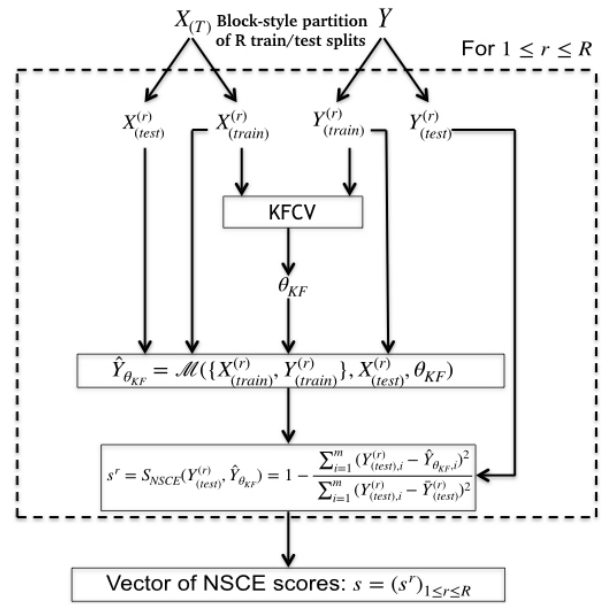
Figure 4. Scheme of the whole procedure for score calculation for a given method M . Y is the index of the chosen mode of variability. X (T) is the proxy dataset restricted to the period where Y known. } is the r th training sample and { X (r) { X (r) , Y (r) ( train ) ( train ) the r th testing sample. θ KF is the empirically optimal set of param- eters obtained by applying the KFCV (Fig. 3; Sect.